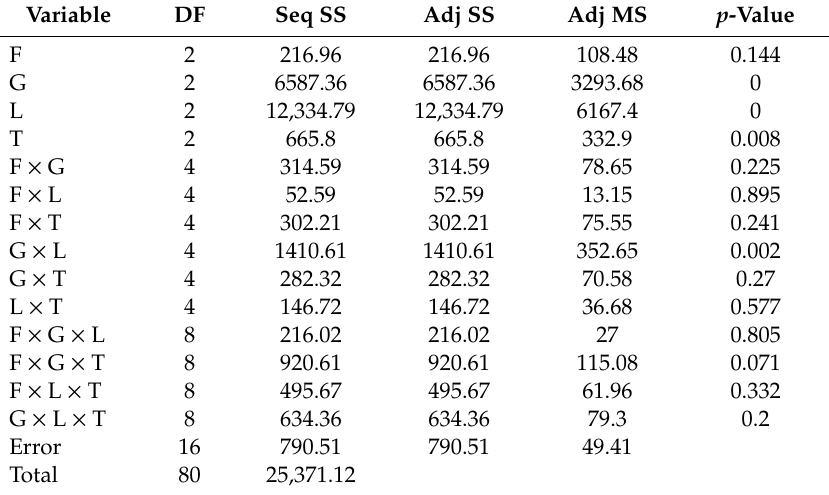
Table 2. ANOVA results for 3 k factorial